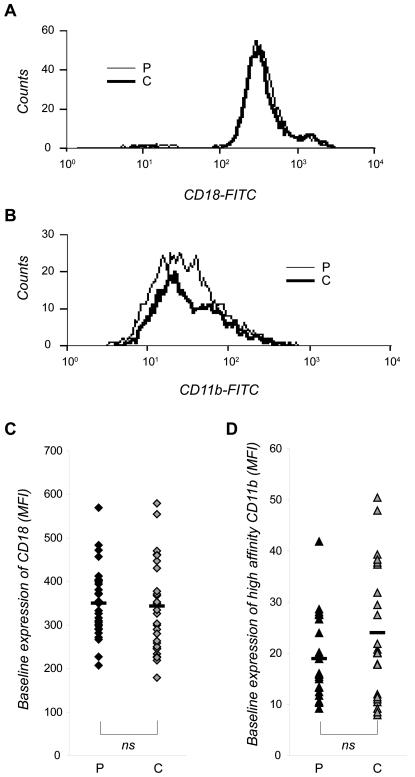
Baseline expression of CD18 and high-affinity state CD11b on neutrophils in patients with stable CAD.Whole blood from patients (P) and individually matched control persons (C) were incubated at 37°C with (A,C) the MHM23-antibody or with (B,D) the CBRM1/5-antibody for 5 and 10 min, respectively, whereafter the samples were incubated on ice. Contaminating erythrocytes were removed by lysis, and antibody bound to CD18 or to CD11b-integrins displaying the high-affinity epitope was detected by FACS analysis. The cells were gated to identify the neutrophil population, and 10 000 cells were analyzed in each sample. Data are shown as one representative histogram plot (A,B) or as median of the mean fluorescence intensity (MFI) values (C,D) from 30 (A,C) and 25 (B,D) experiments per cohort done in triplicate. Mean value is indicated as a black hyphen. Wilcoxon signed-ranks test was used to determine significance between each patient and its individually matched control.